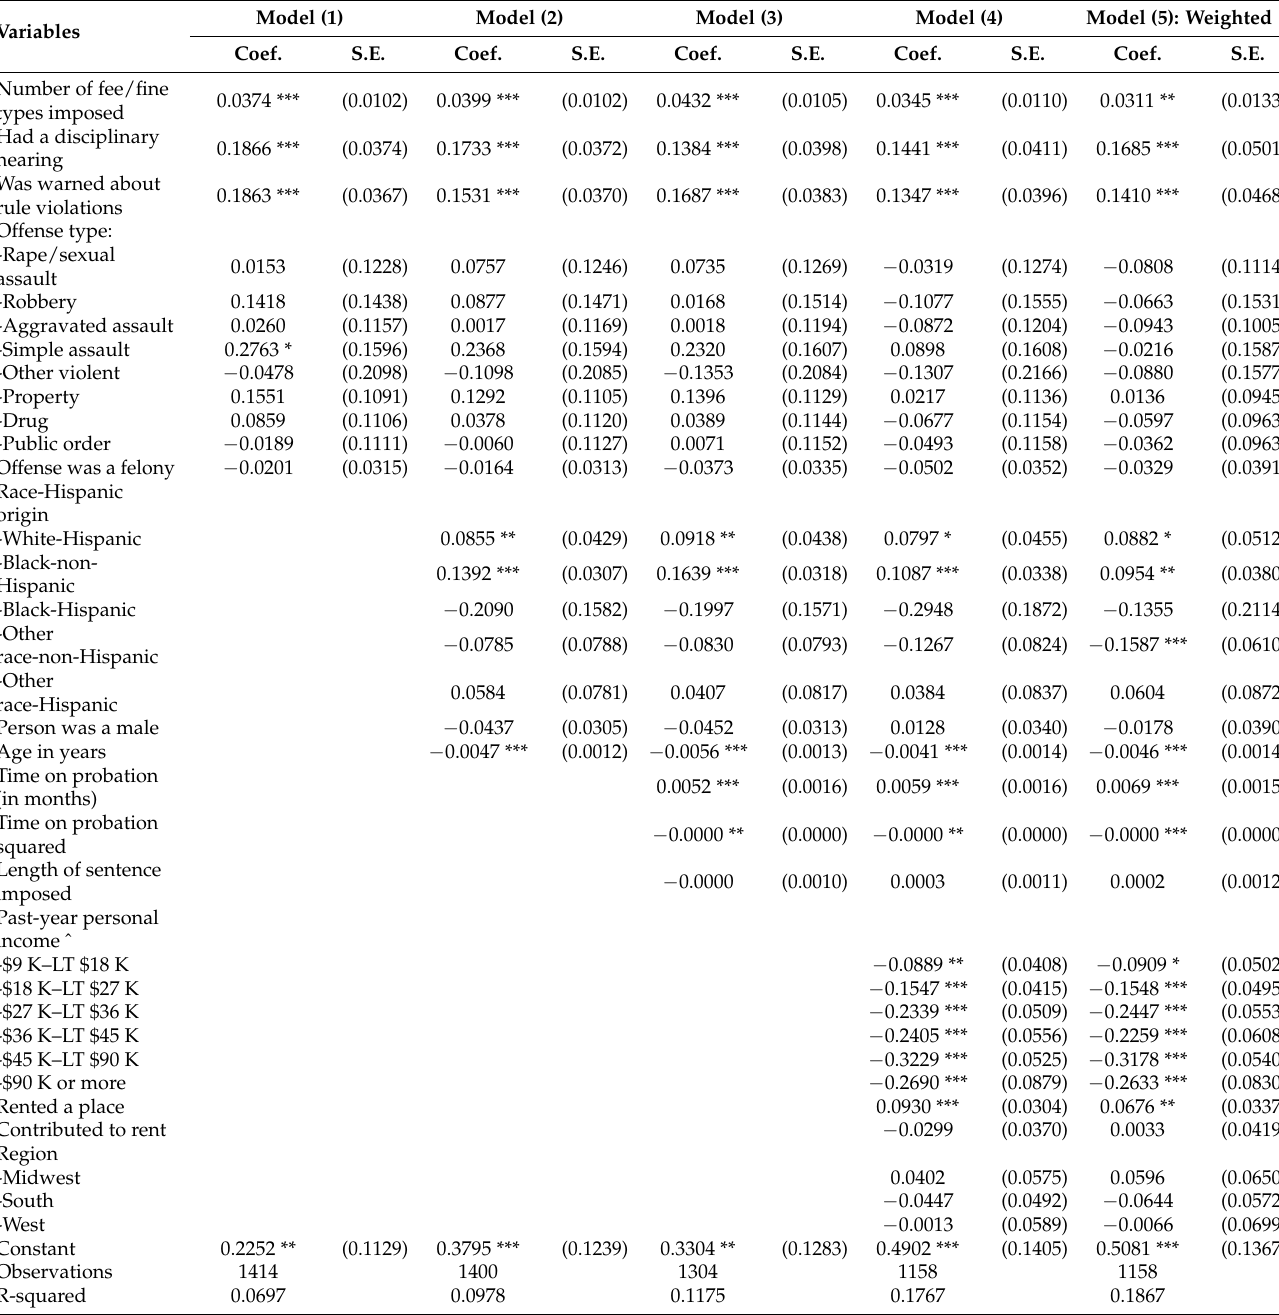
may indicate specification error arising from sample design. We find no evidence for this. We use the unweighted results because the standard errors are most efficient. Table 4. Linear probability model estimates of the probability of missing a payment as function of the number of regular fee/fine types ordered. Coefficients are probabilities. Model (5) are weighted estimates using the final weight for the personal interview sample of the